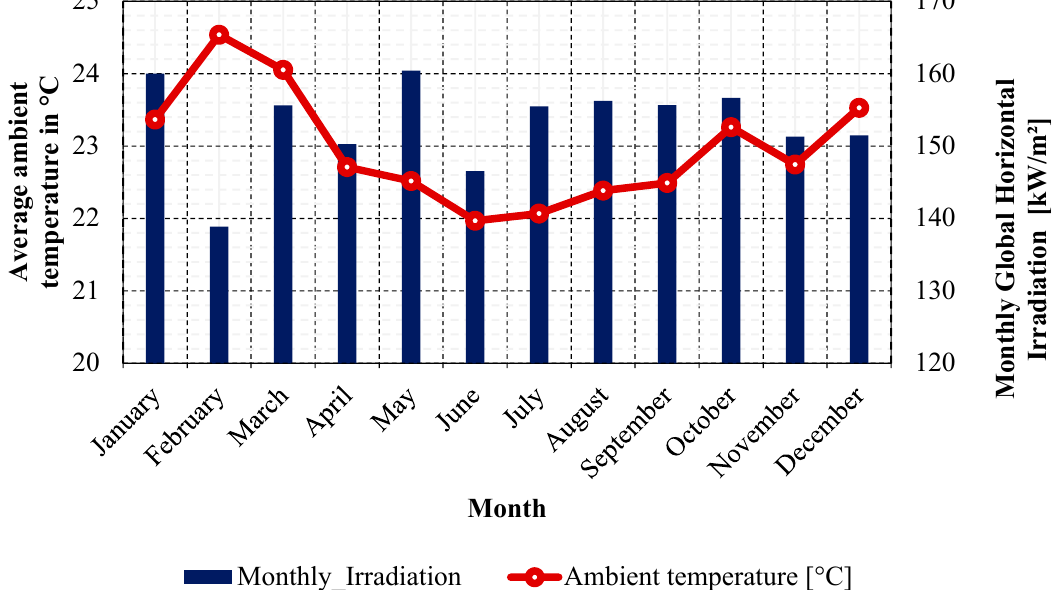
Figure 13. Solar irradiation and ambient temperature of the selected Figure 13 . Solar irradiation and ambient temperature of the selected location.